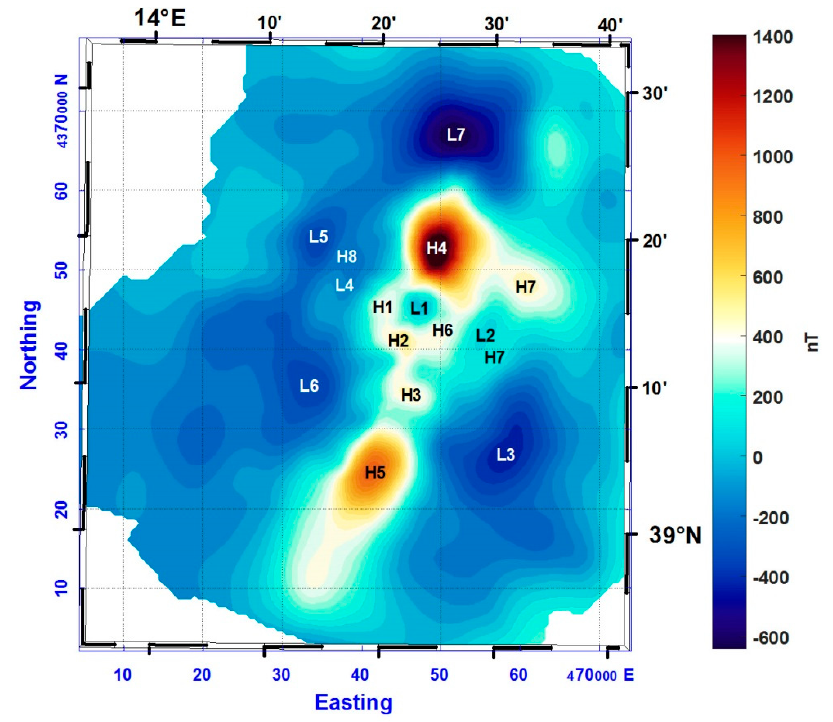
Figure 12. Total field shipborne magnetic anomalies in the area of Marsili Seamount (digitized from [29]). Letters identify magnetic anomalies described in the text.